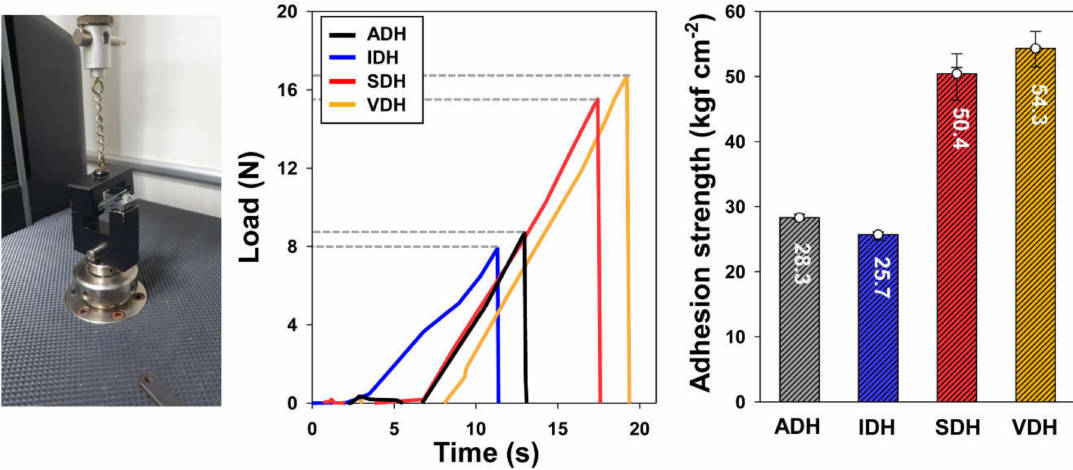
Figure 5. Results of pull-off test for various epoxy resin